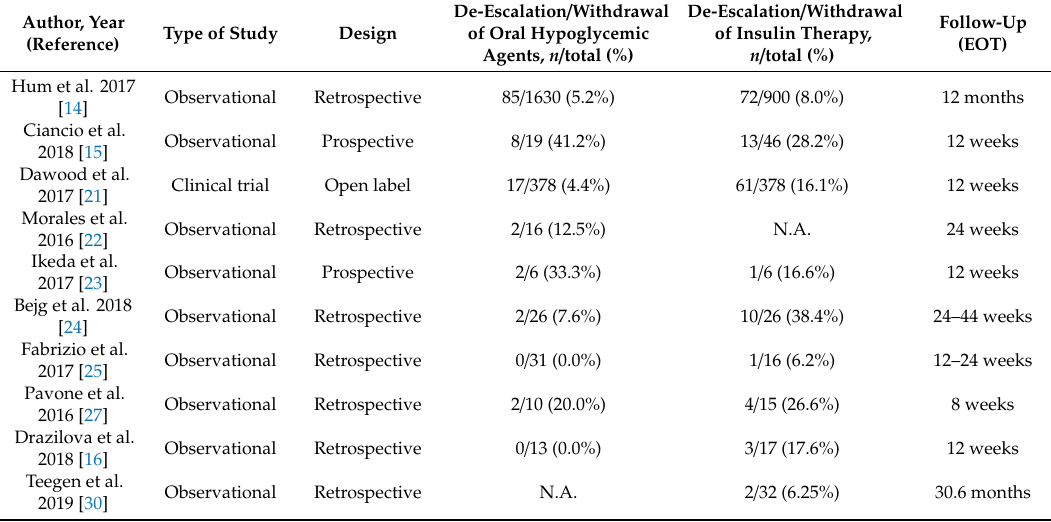
Table 5. Studies reporting de-escalation / withdrawal of antidiabetic therapy in HCV-positive diabetic patients with DAA-induced